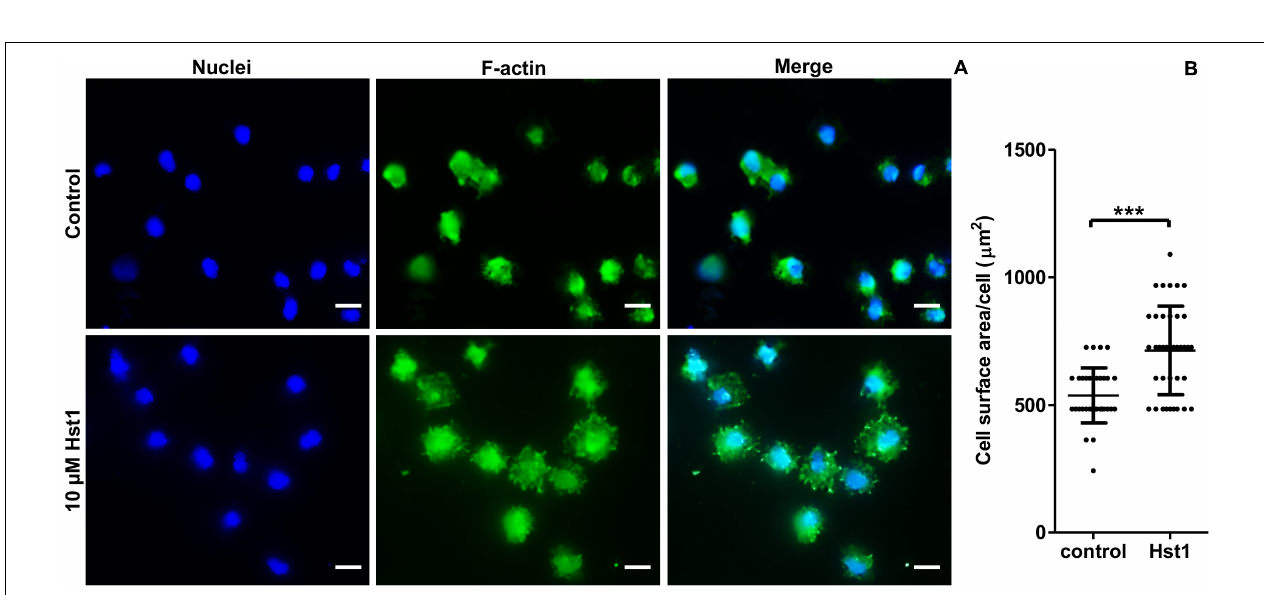
FIGURE 5 | Hst1 promoted the spreading of osteogenic cells on titanium SLA surfaces. Fluorescent micrographs (A) depicting the spreading of osteogenic cells that were stained by Dapi (for nuclei) (left column) and by FITC-Phalloidin (for F-actin) (middle column) Bar = 20 µ m. (B) Graph depicting the quantitative analysis of the spreading of osteogenic cells. Data are shown as mean ± SD ( n = 32). *** p < 0.001.